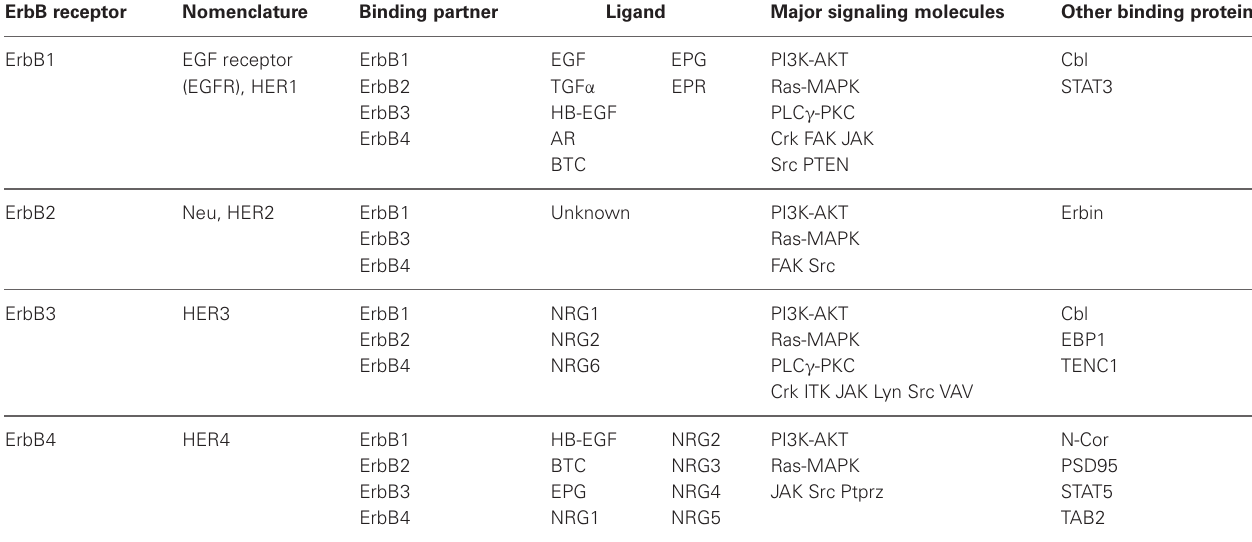
Table 1 | ErbB molecules and their ligands and